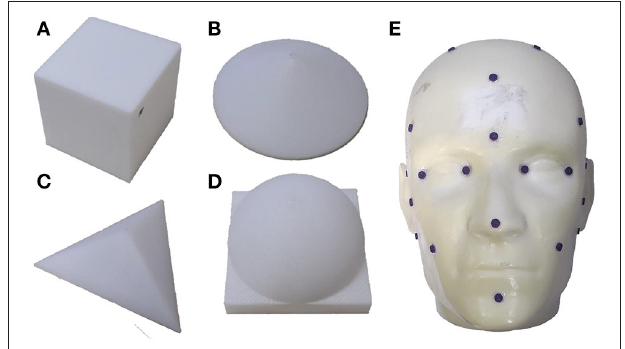
FIGURE 6 | 3D models used in the experiments. Regular models: (A) cube; (B) cone; (C) tetrahedron; and (D) hemisphere. Irregular model: (E) head